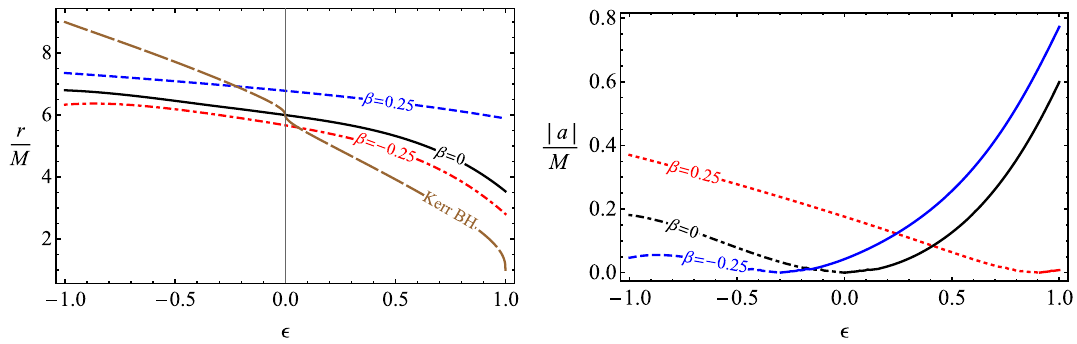
spin of a Kerr BHs a and the deviation parameter (cid:2) for the different values of the magnetic coupling parameter β = 0 . 25 , 0 , − 0 . 25